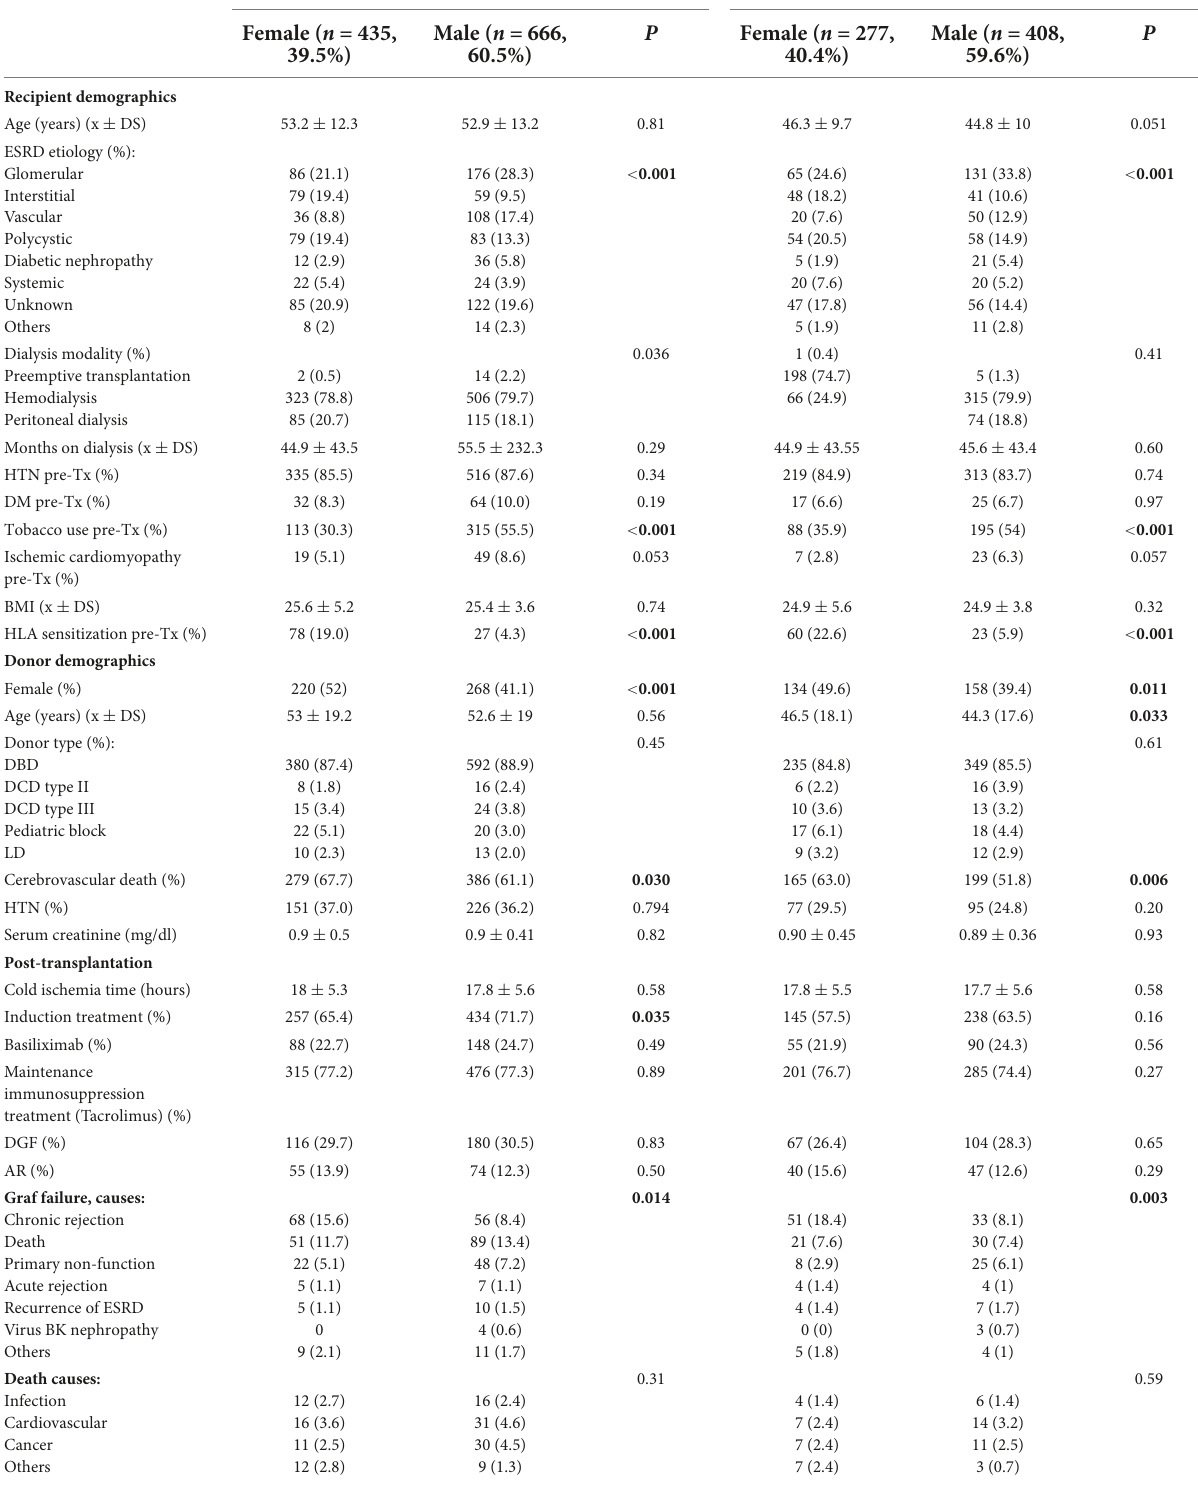
TABLE 1 Demographic characteristics of recipients, donors, and post-transplant variables depending on recipient sex in the whole study population and the adult recipients younger than 60 years. Global series ( n =